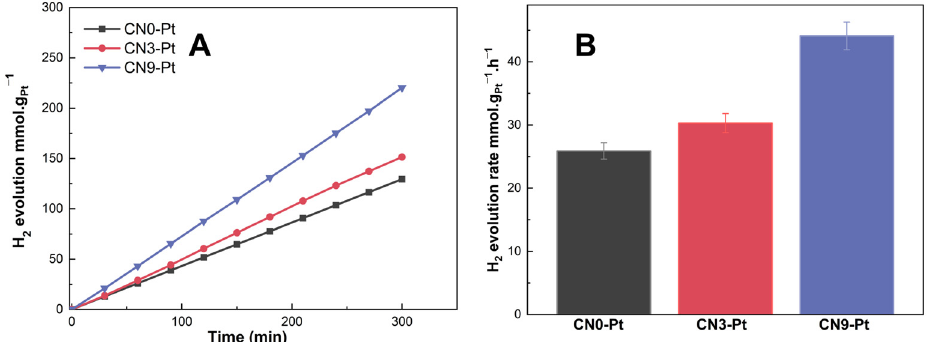
Figure 6. ( A ) Hydrogen evolution of CNx-Pt ( µ mol. g Pt − 1 ) over time (min) and ( B ) hydrogen evolu ‐ tion rate of CNx ‐ Pt ( μ mol.g Pt − 1 .h − 1 ).